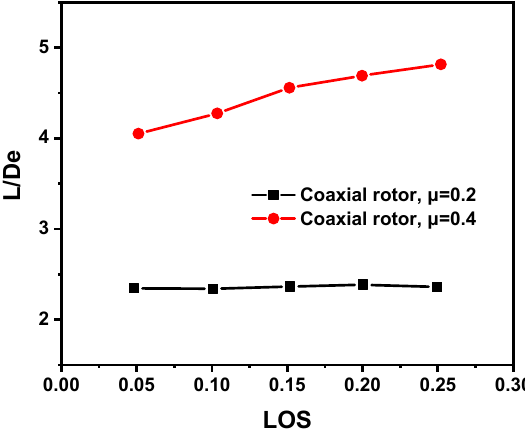
Figure 19. L/De ratio as a function of the lift offset (LOS).